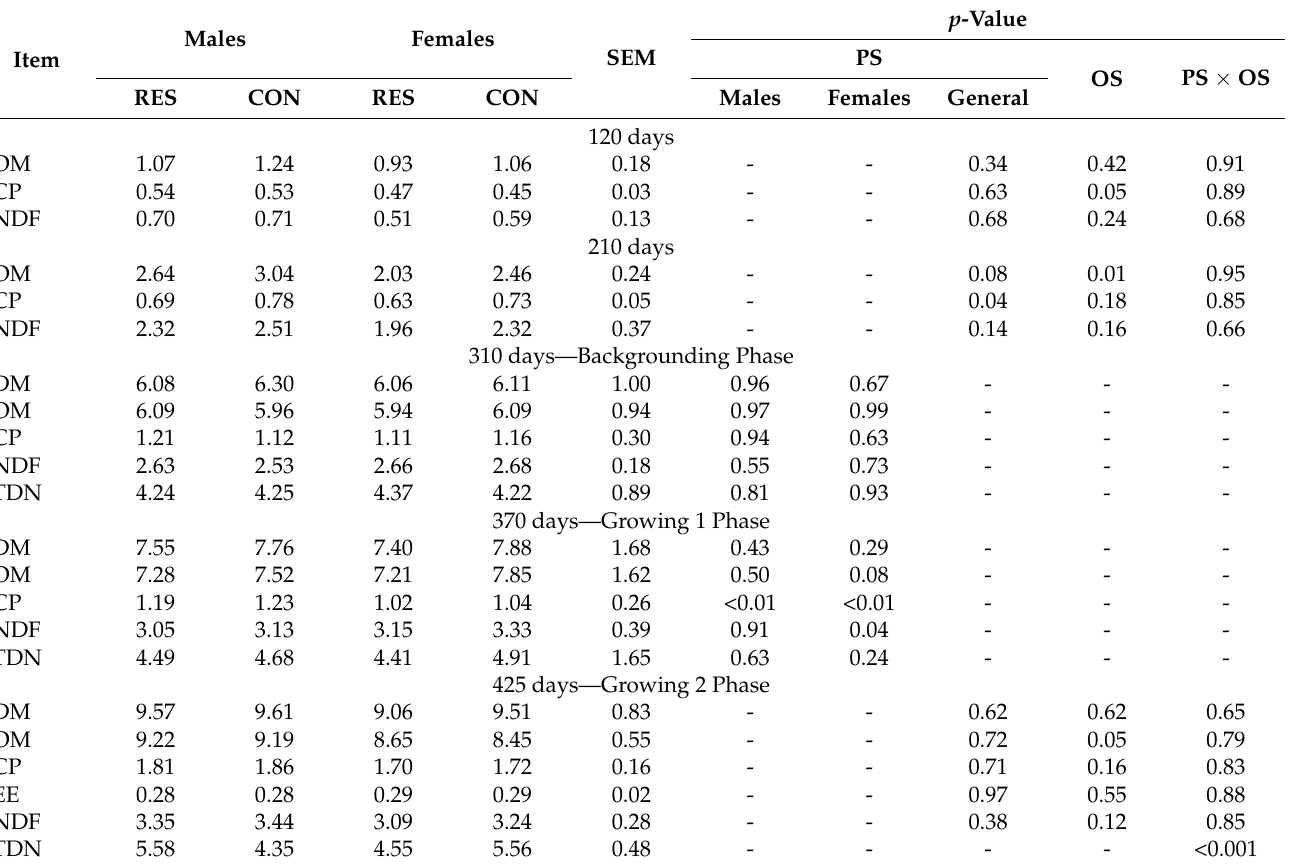
Table 5. Effects of maternal protein supplementation status (PS) and offspring sex (OS) on diet component intake during the digestibility trials, expressed in kg/day.